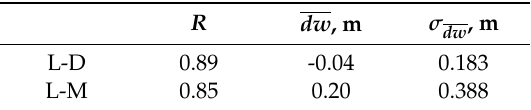
Table 2. Statistical assessment of the DInSAR (D) and model (M) data compared to the verification data from levelling (L).